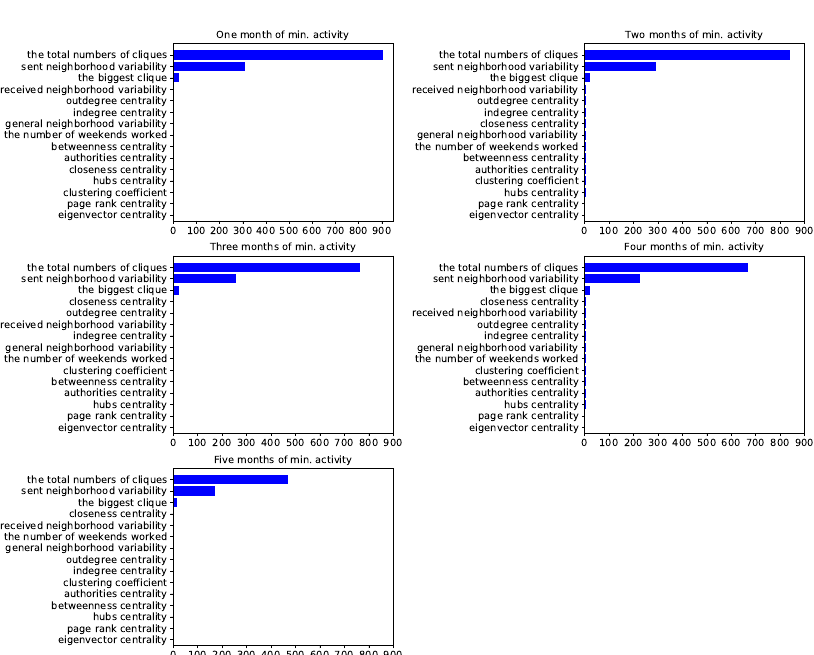
Figure A12. Features importance (based on univariate feature selection method which uses chi-squared test) for the Neural Network and SVM which use the full set of features for the Enron dataset with three levels of the